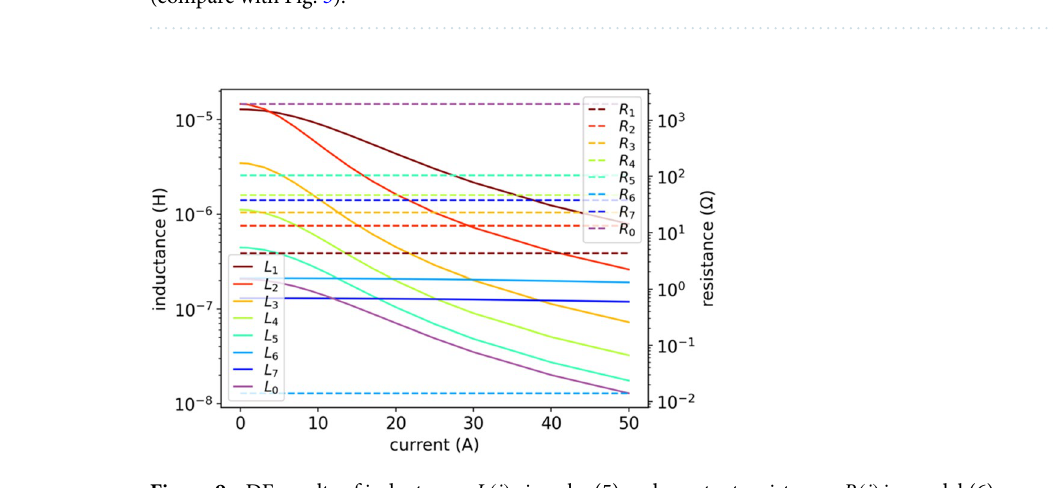
Figure 9. DE results of inductances L ( i ) given by (5) and constant resistances R ( i ) in model